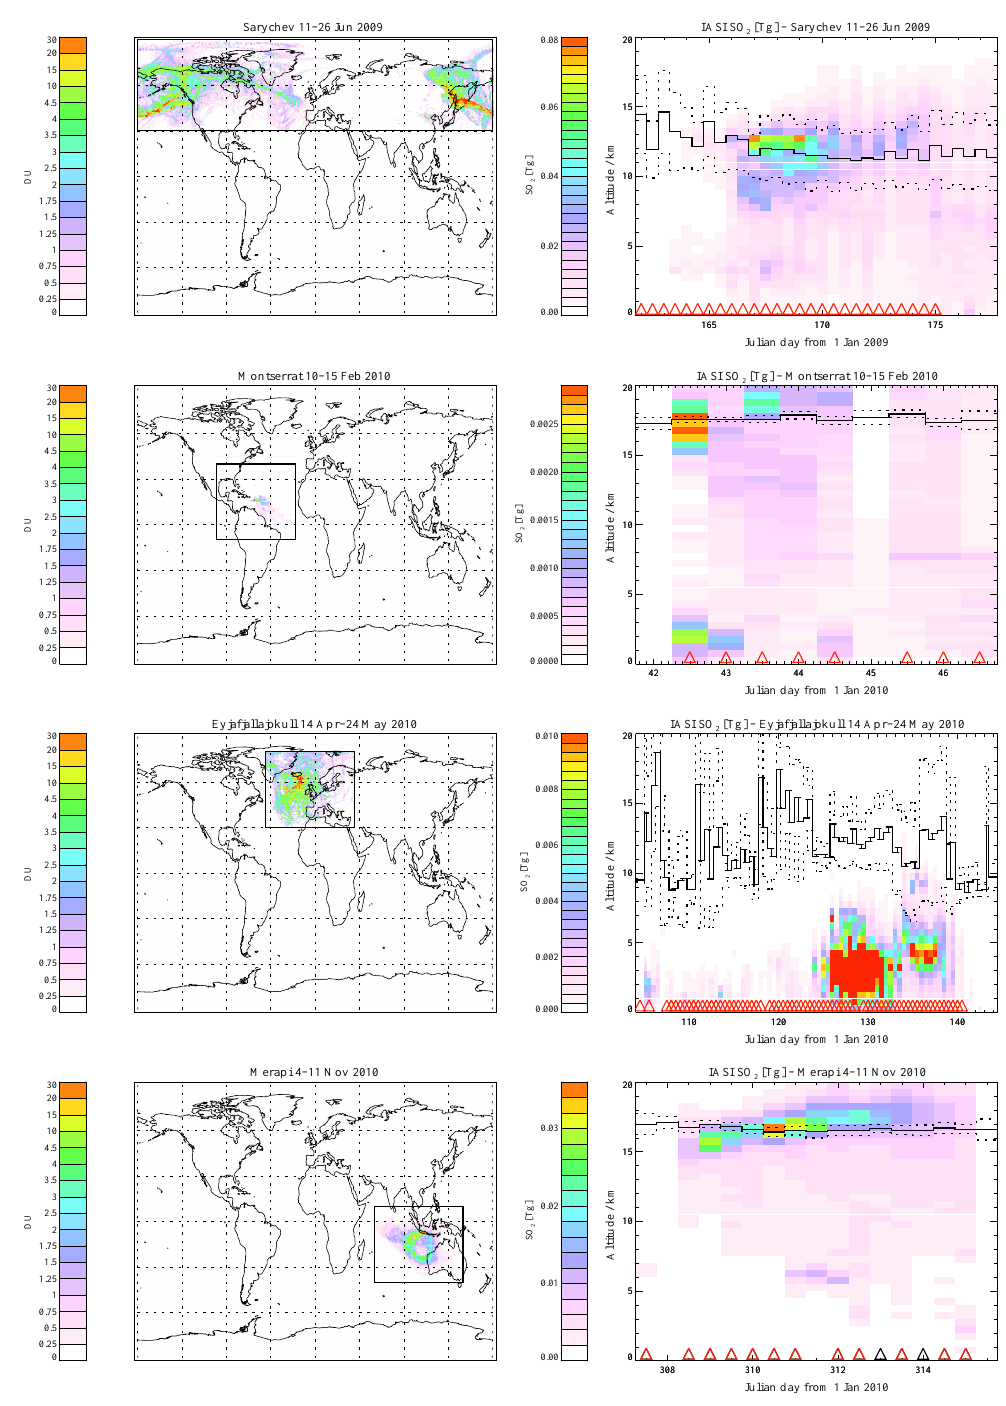
Figure 9. As for Fig.